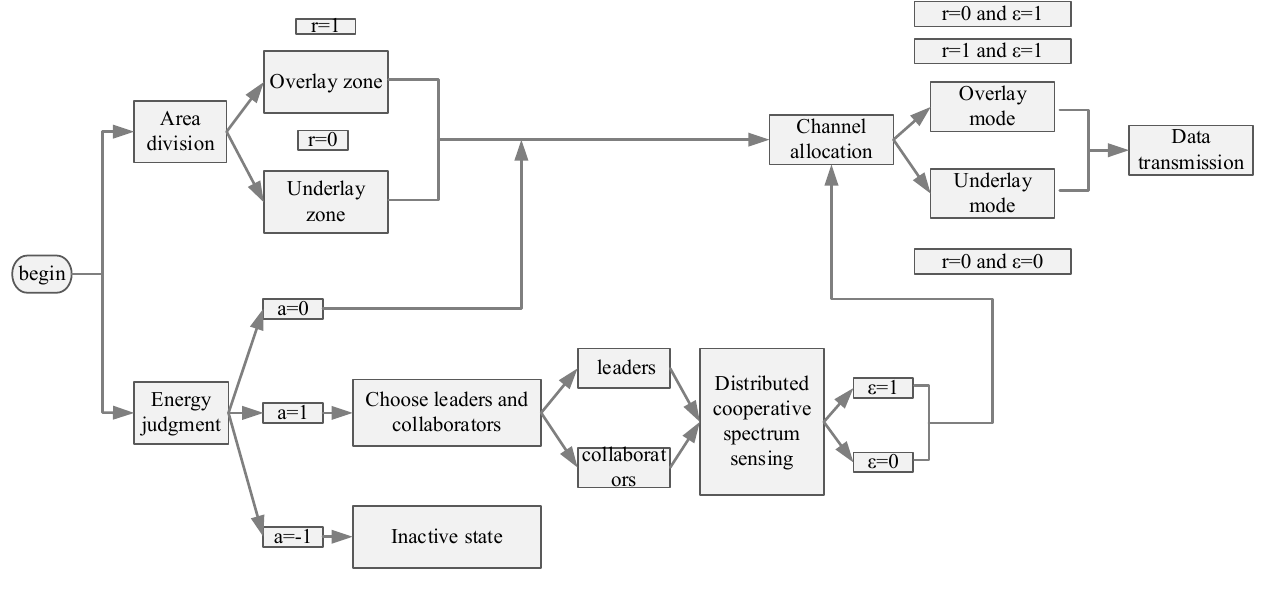
Figure 5. System flow chart.